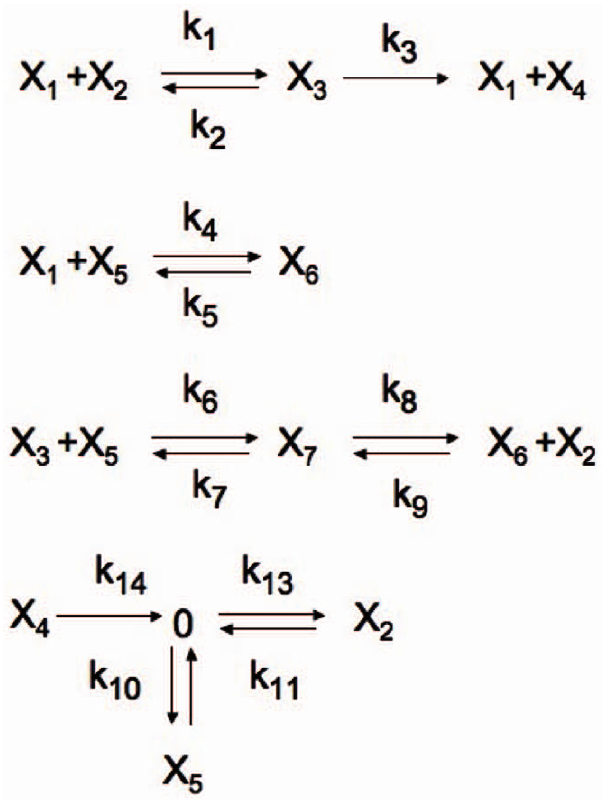
Figure 4. A new model for receptor induced apoptosis.